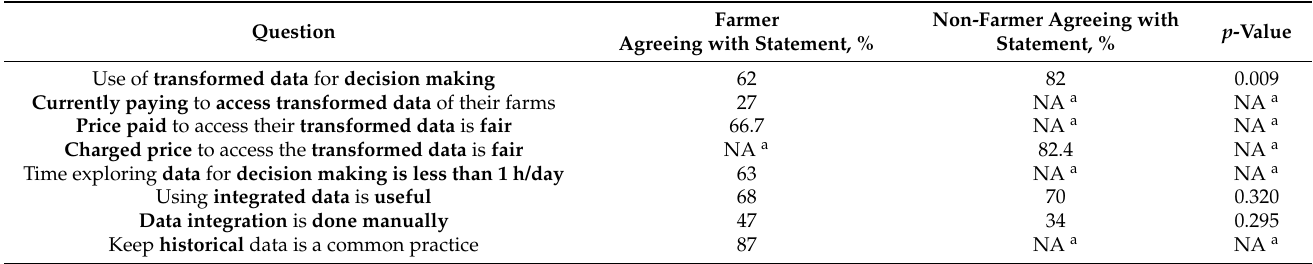
Table 2. Response summary of the data uses, data access, data transformation, and data integration.